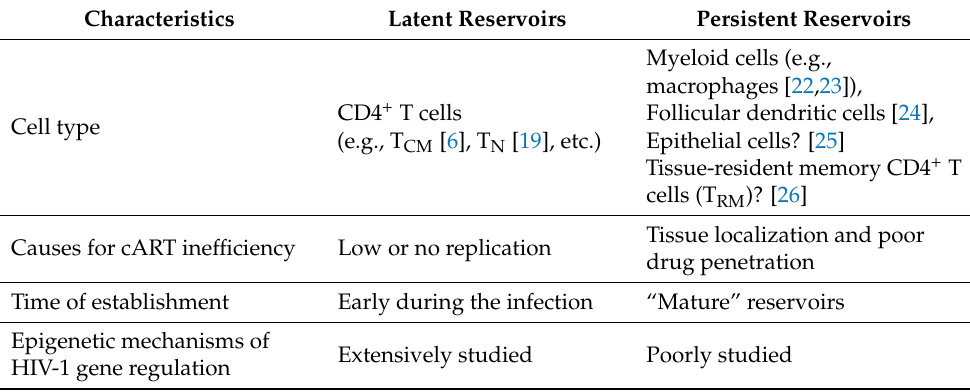
Table 1. Latent and persistent reservoirs for